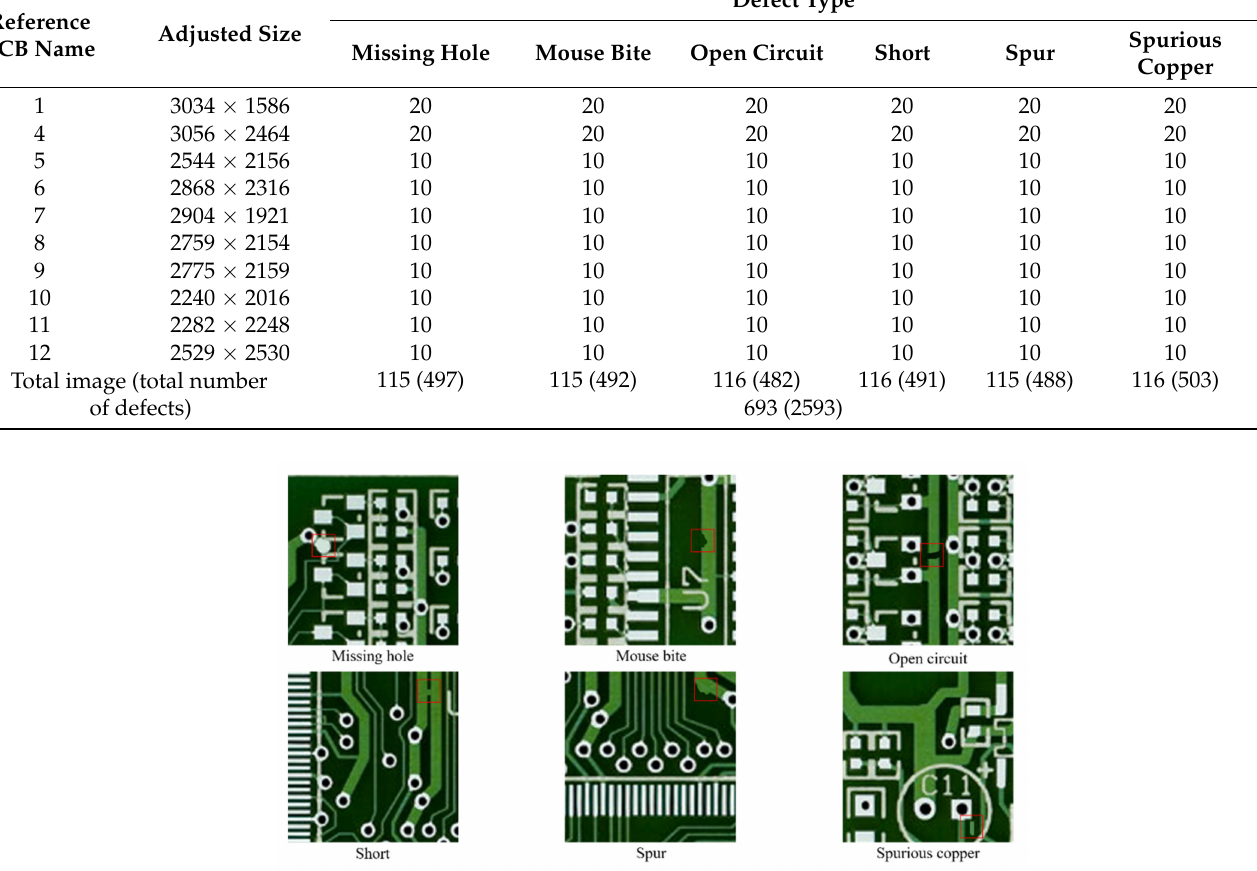
Figure 2. Examples of PCB